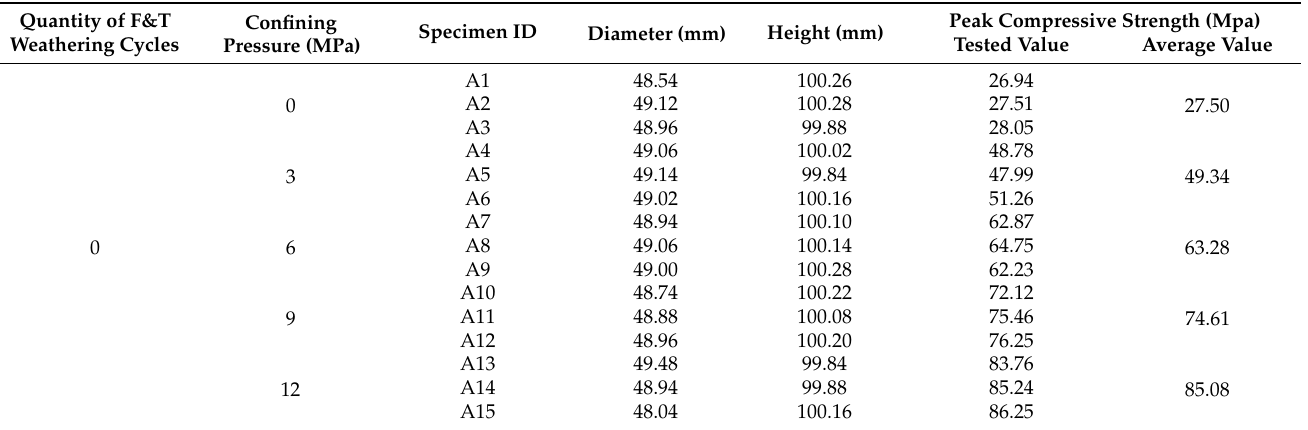
Table 2. Uniaxial and triaxial compression test results for sandstone specimens after undergoing different quantities of F&T weathering